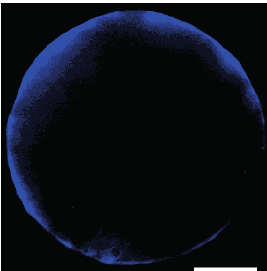
Figure 5. Cell wall regeneration in an egg protoplast fused in vitro with the sperm in Ca 2+ -free IVF medium. The image was taken 2 h after the sperm–egg cytoplasmic continuity had been established. Scale bar, 12.5